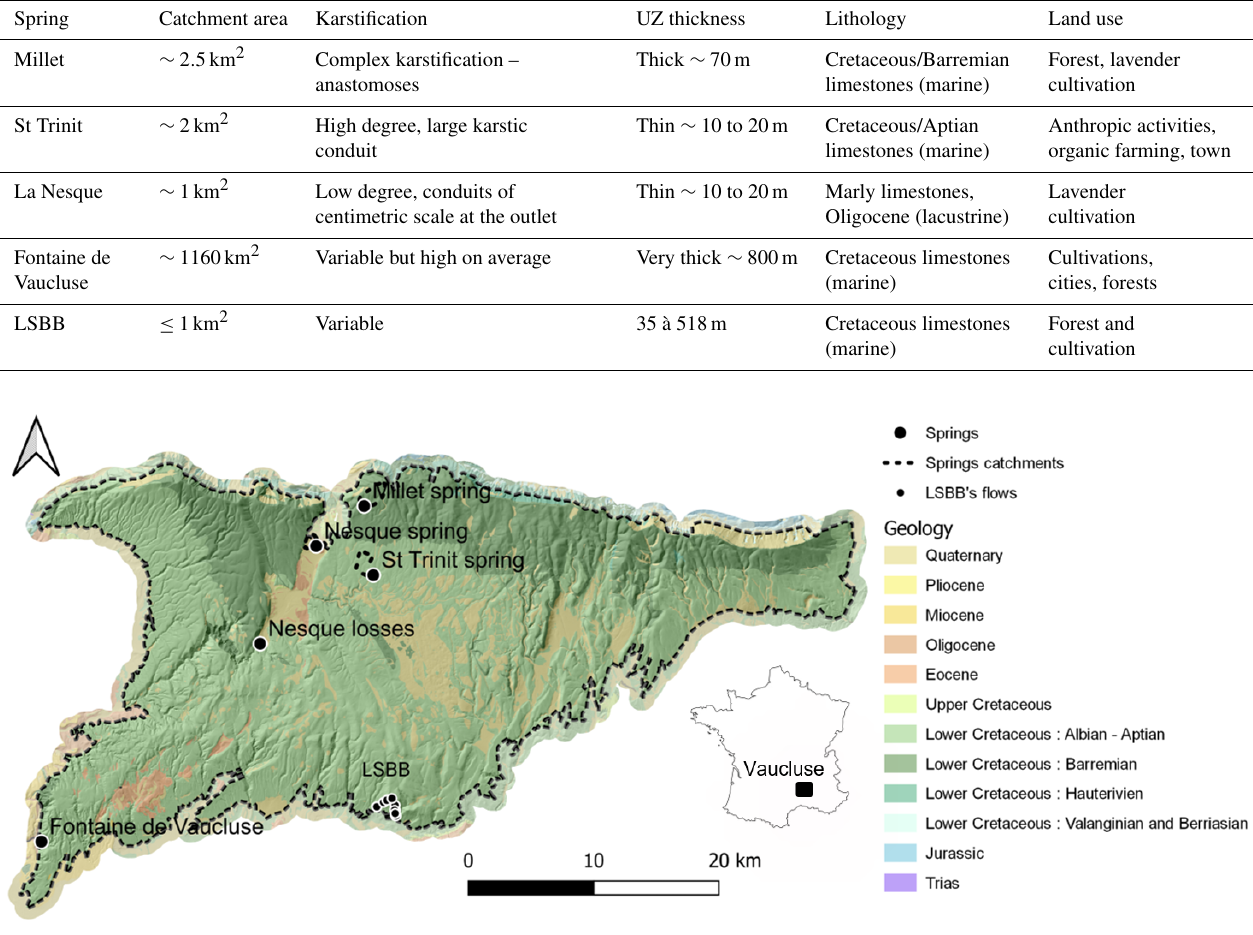
split-half analysis, Tucker’s congruency, plotting of compo- nents, and random initialization (Andersen and Bro,